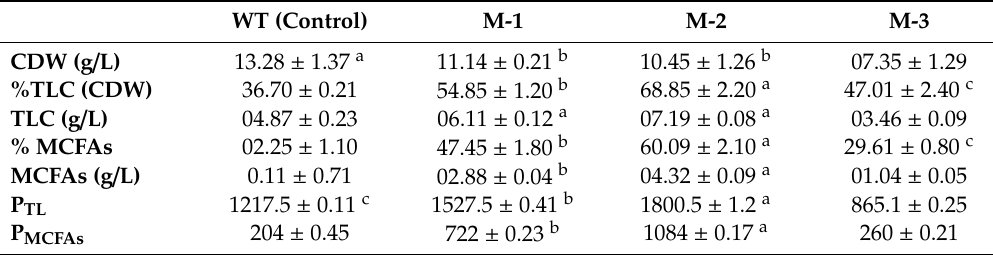
Figure 8. ( A ) Fatty acid (FA) profiles of the control (WT) and engineered strains, ( B ) Abundance of medium-chain lipids, ( C ) 16-carbon lipids, and ( D ) 18-carbon lipids from engineered strains of M. circinelloides (MU758) in different lipid classes, i.e., free fatty acids (FFA), triacylglycerol (TAG), diacylglycerol (DAG), monoacylglycerol (MAG), sterol, and steryl ester (S. ester). Table 2. Fatty acid portfolio in control and mutant strains of M. circinelloides